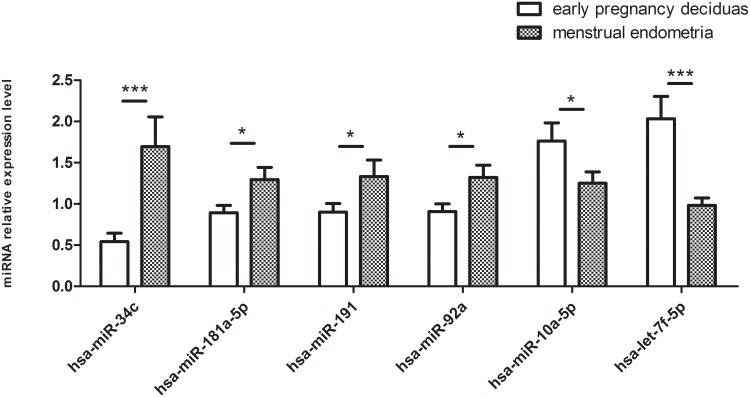
Validation of the differential expression of six known miRNAs by qPCR analysis.The miRNA expression level was normalized to that of U6 snRNA. “*” represents P value <0.05, “**” represents P value <0.01, and “***” represents P value <0.001. All experiments were repeated with 3 replicates.